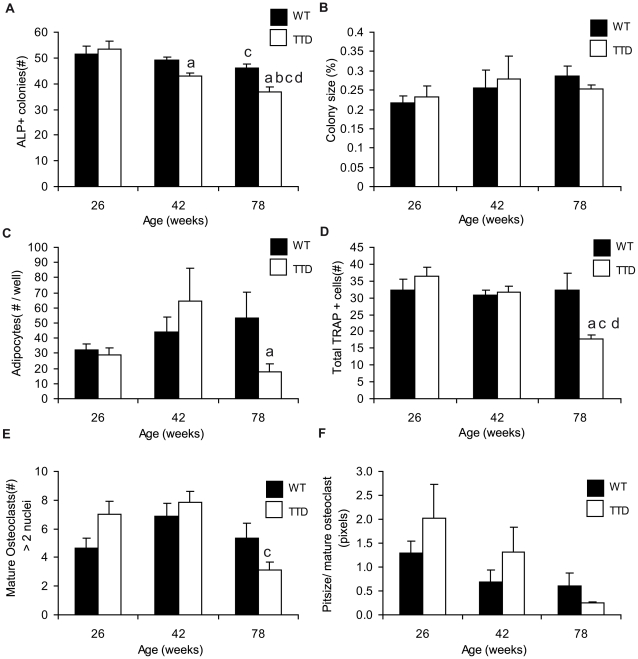
Mesenchymal and hematopoietic stem cell differentiation.Mesenchymal and hematopoietic stem cell differentiation in aging wild type (solid bars) and TTD males (open bars). (A) Average number of ALP+ colonies in ex vivo bone marrow cultures after 14 days of culture. (B) Average colony size at day 14 of culture. (C) The average number of adipocytes per well. (D) Average number of TRAP+ positive cells per picture. (E) Average number of mature osteoclasts per picture. (F) Average percentage resorption surface per osteoclast pit per mature osteoclast. Statistics: a= student t-test; p<0.05 wild type vs. TTD, b−d = 2 way ANOVA; p<0.05. b= significant difference between wild type and TTD with aging, c= signifcant difference with aging within a genotype, d= a significant interaction between age and genotype. Error bars represent SEM.